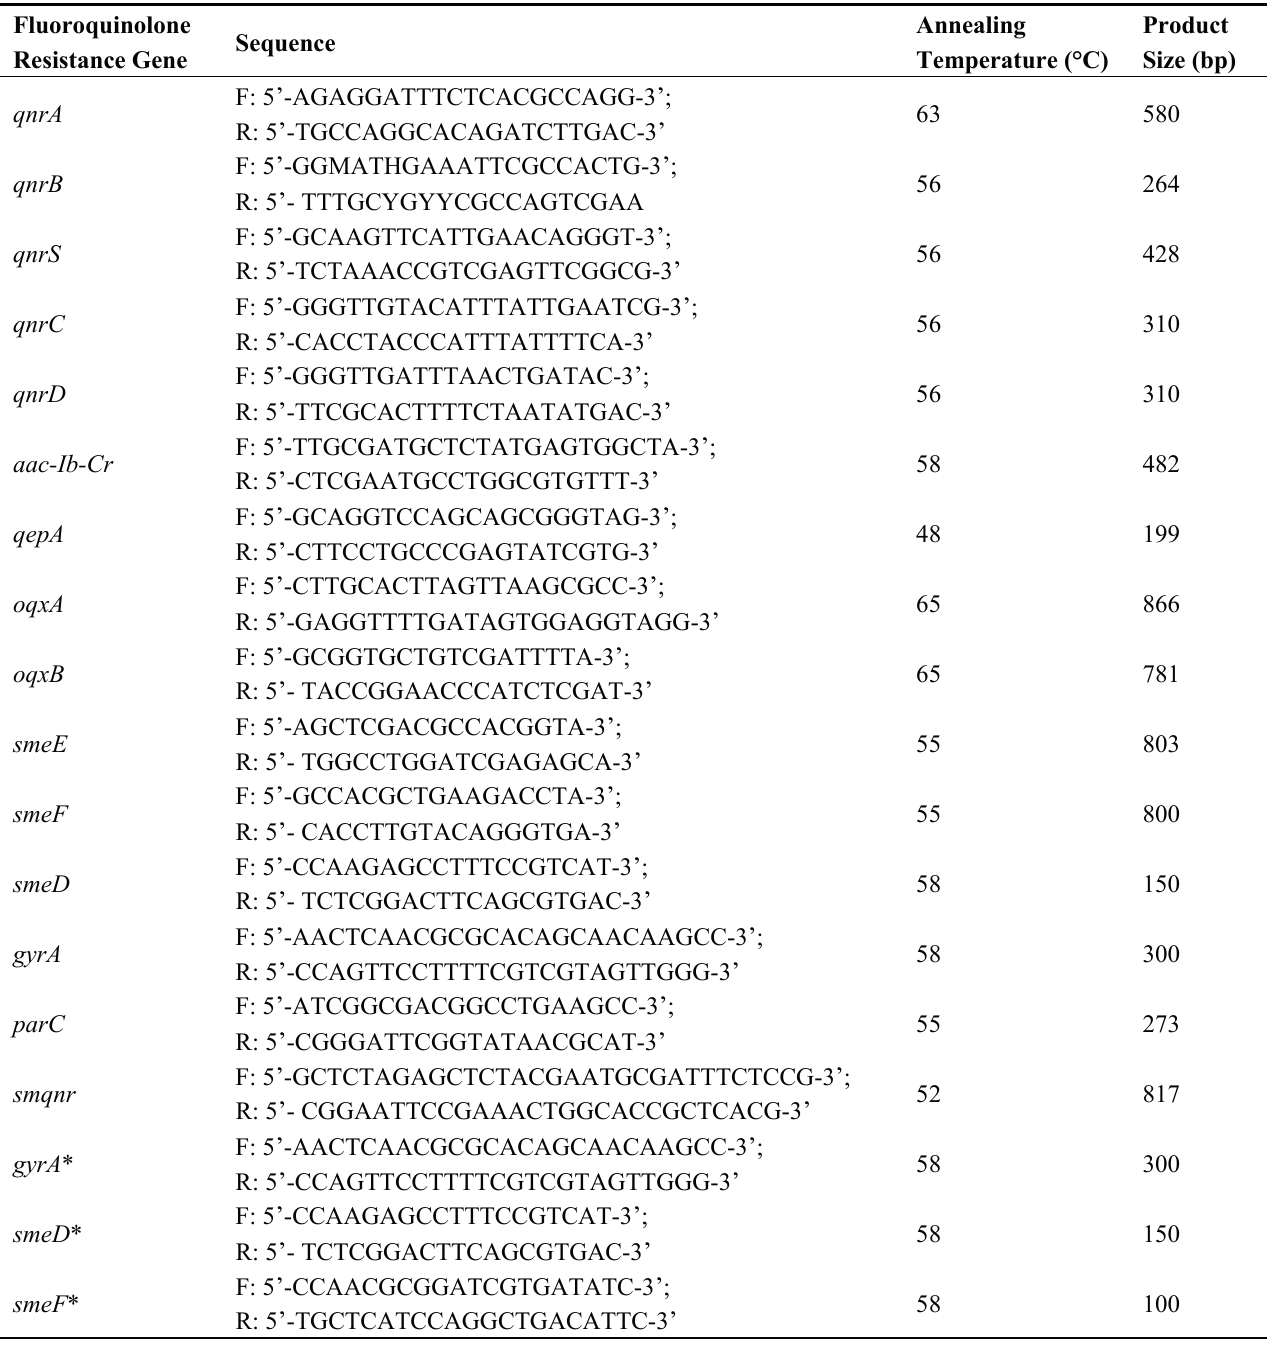
Table 1. PCR primer sequence and PCR product